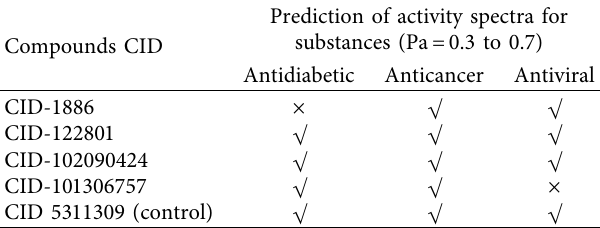
Table 6: QSAR-based bioactivity prediction for ligand validation. Prediction of activity spectra Compounds CID